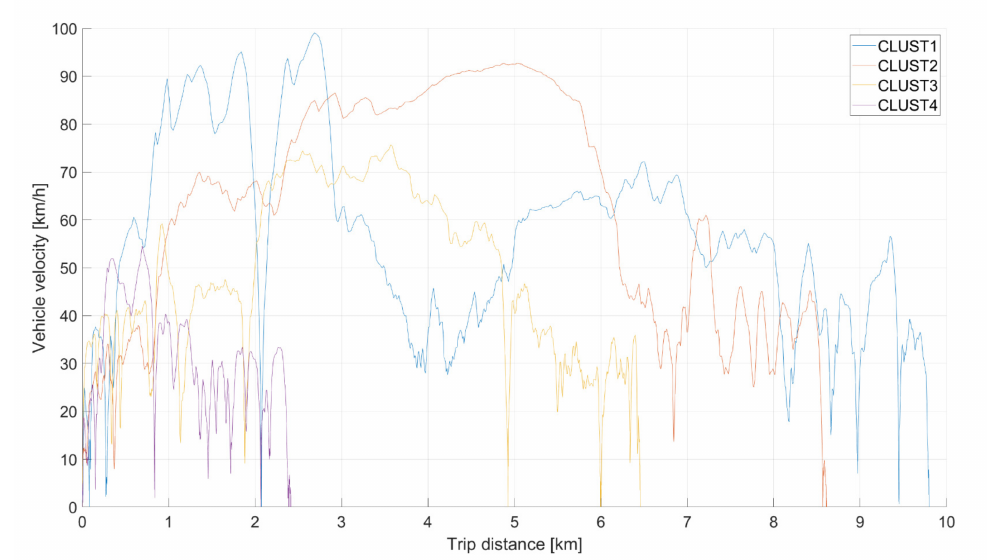
Figure 5. Comparison of the vehicle velocity trajectories as a function of the distance covered between CLUST1, CLUST2, CLUST3 and